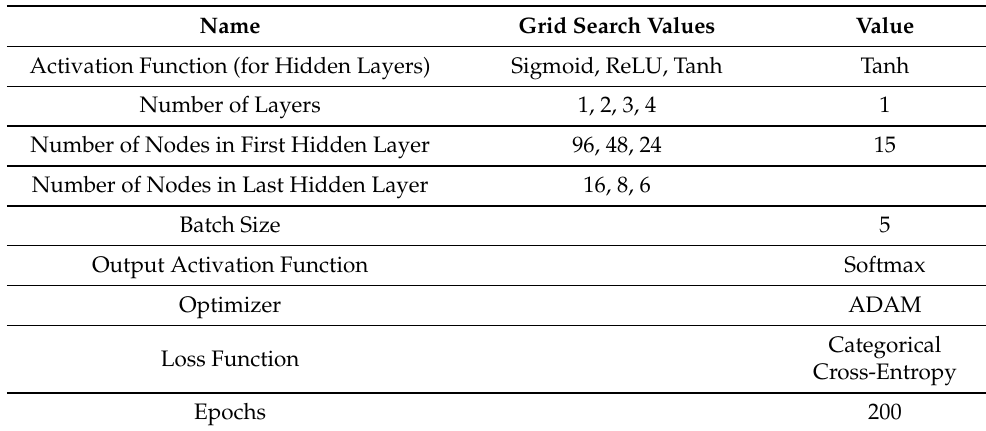
Table 4. Parameters for neural network